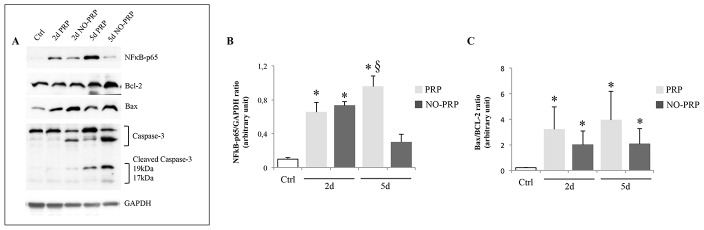
Effect of PRP treatment on several apoptotic markers during regeneration process (2- and 5-day postinjury).(A) Representative immunoblot of each protein marker reported; (B) NF-κB-p65, and (C) Bax/Bcl-2 ratio. Values are means ± SEM (n  =  5/group at each point). * p< 0.05 vs. Ctrl group.§ p< 0.05 vs. 5d NO-PRP group.